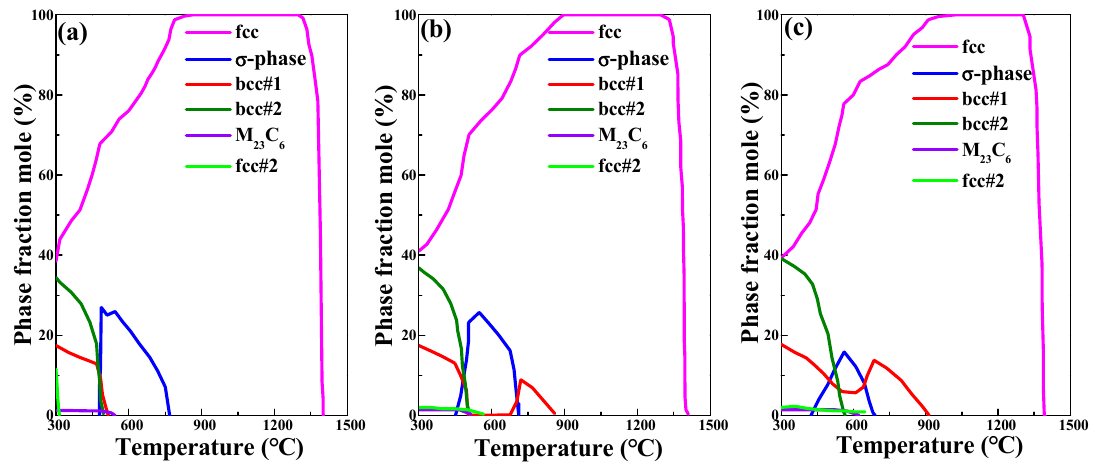
Figure 2. Equilibrium phase diagrams of new alumina-forming austenitic heat-resistant steels: ( a ) 1.5Al; ( b ) 2.5Al; ( c ) 3.5Al.